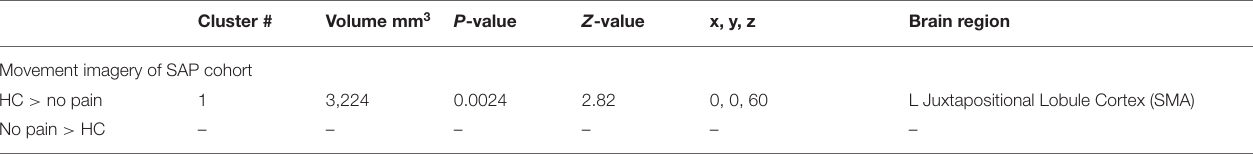
TABLE 7 | Activated brain regions within each between-group contrast for SAP performing a movement imagery task. Cluster # Movement imagery of SAP